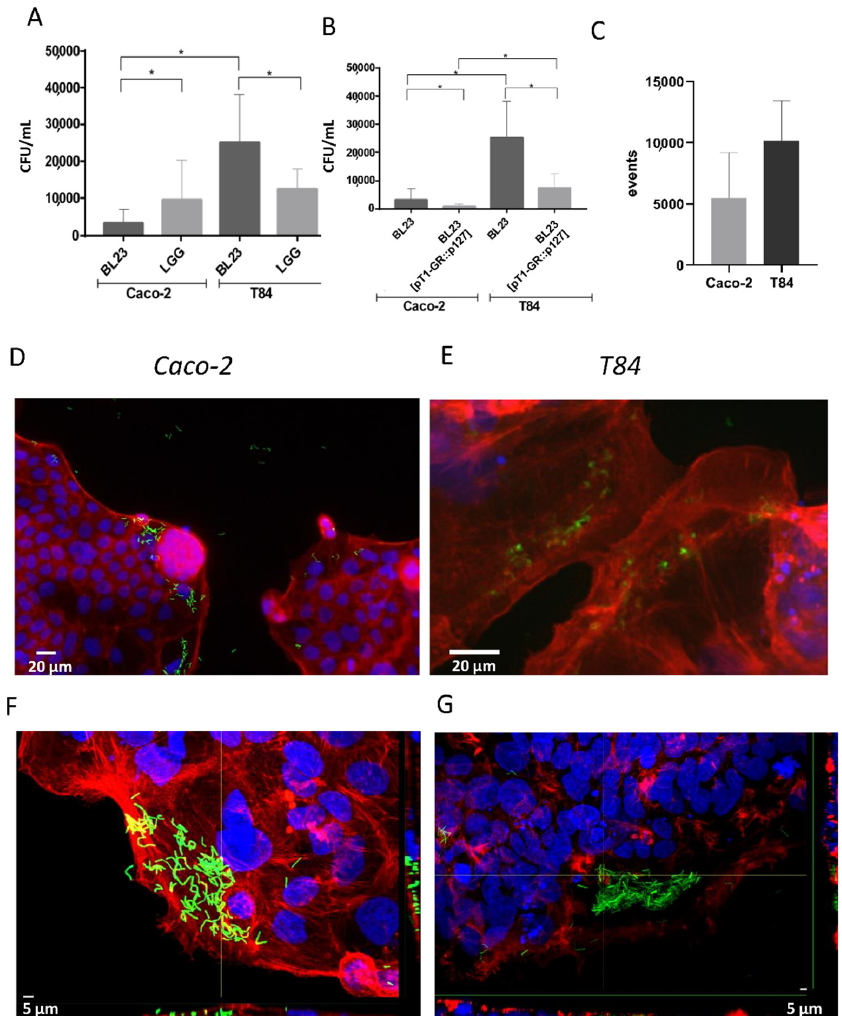
Figure 1. Different techniques used to determine spontaneous internalization of lactobacilli. ( A ) Internalization of BL23 and LGG in Caco-2 and T84 determined by the gentamicin protection method, and data represent means of CFU per mL specific assays and controls from other assays (a total of 64 experiments, with three replicates per assay, a total of 192 determinations), bars indicate standard deviations. ( B ) Assay showing differences in the internalization efficiency between BL23 and the recombinant strain carrying plasmid pT1-GR::p127 used in microscopic observations, as it allowed the expression of fluorescent proteins GFP and RFP (results from four separate assays, with three internal replicates per condition). ( C ) Internalization of BL23 [pT1-GR::p127] determined by flow cytometry in Caco-2 and T84; graph represents the means and standard deviation of red fluorescent events in two different assays with at least three determinations. Differences between groups compared with Tamhane’s test. * p < 0.001. ( D , E ) Epifluorescence photographs showing internalization of BL23 [pT1-GR::p127] by ( D ) Caco-2 and ( E ) T84 cells. White scale bars represent 20 µm. ( F , G ) confocal microscopy photographs showing internalization of BL 23 [pT1-GR::p127] by ( F ) Caco-2 and ( G ) T84 epithelial cells; orthogonal projections are shown at the bottom and right hand side of each photograph. White scale bars represent 5 µm.